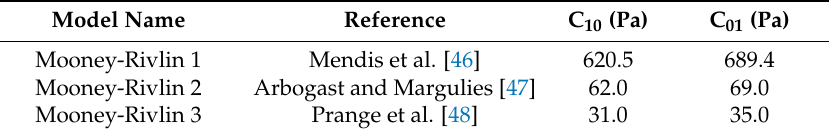
Table 4. Parameters of the Mooney-Rivlin model used in the current